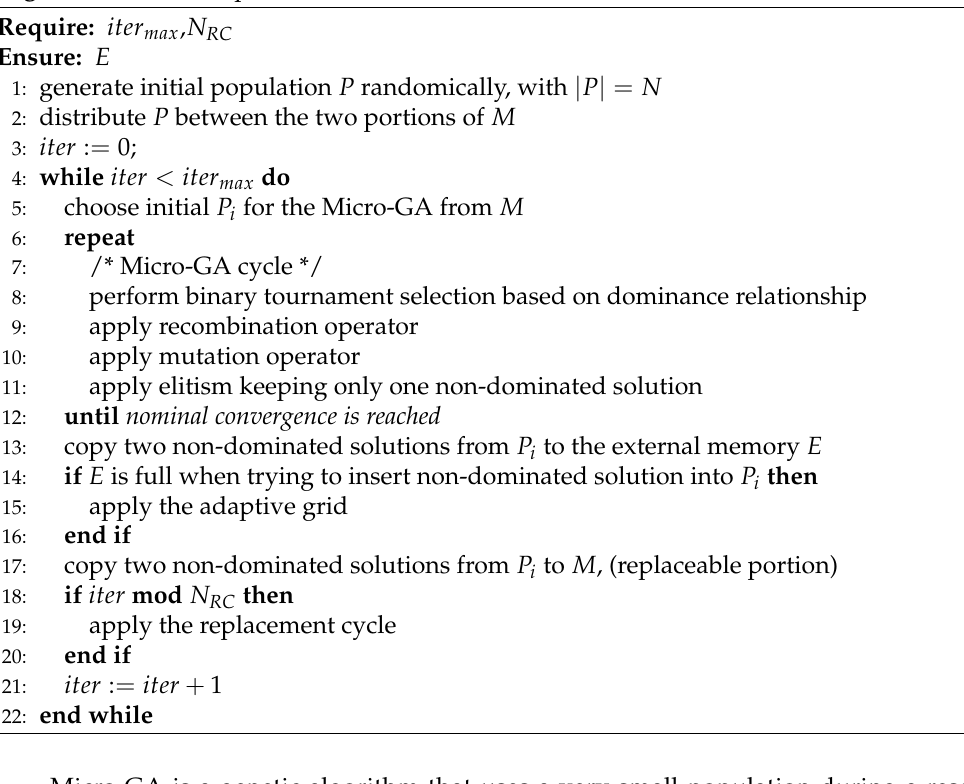
Algorithm 4 Main steps of